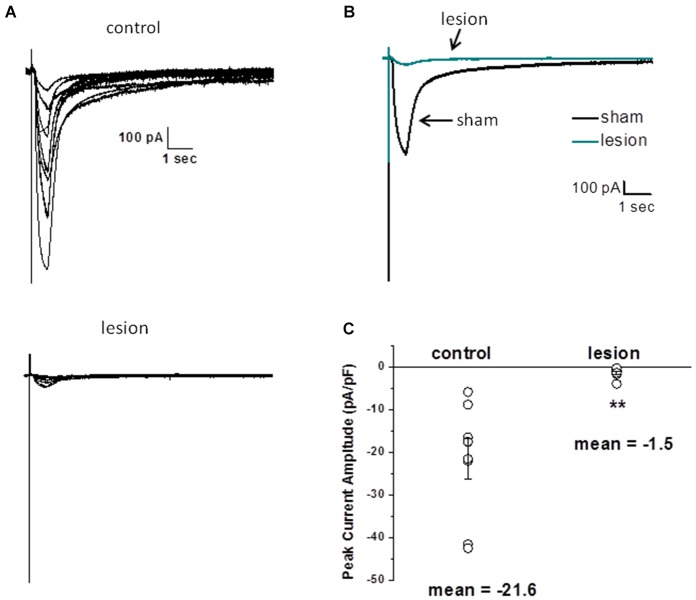
Astrocyte responses to exogenously applied glutamate are reduced in lesioned cortex. (A) Specimen records of glutamate evoked currents from astrocytes in slices from sham-operated (upper) or lesioned (lower) animals. Cells were voltage clamped at −80 mV and responses were evoked by a 500 µM, 0.5 s puff of glutamate. Bathing and puffing solutions contained 50 µM TTX, 200 µM AP5, 200 µM bicuculline, 250 µM CNQX and 100 µM CdCl. (B) Same data as in A but responses averaged across cells are shown. (C) Summary histogram showing that glutamate evoked responses, normalized for cell capacitance, were significantly reduced in the lesioned group.